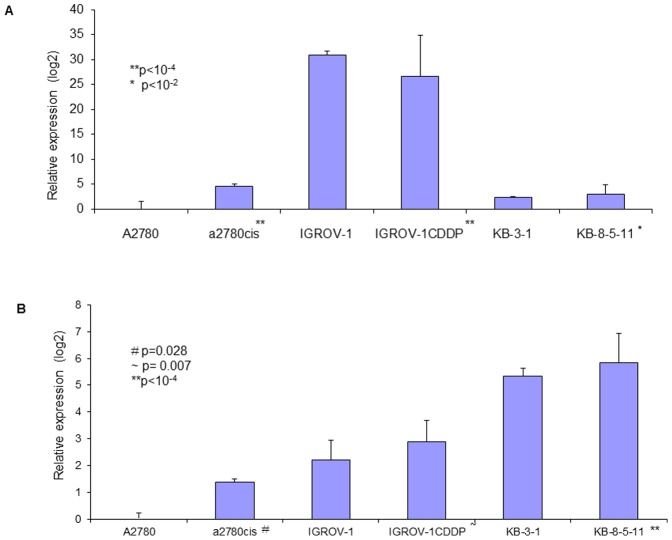
Changes in TLR4 (A) and MyD88 (B) mRNA expression between chemosensitive and chemoresistant cancer cells.Data are expressed as fold change in expression with respect to A2780 cancer cells (with standard deviation).